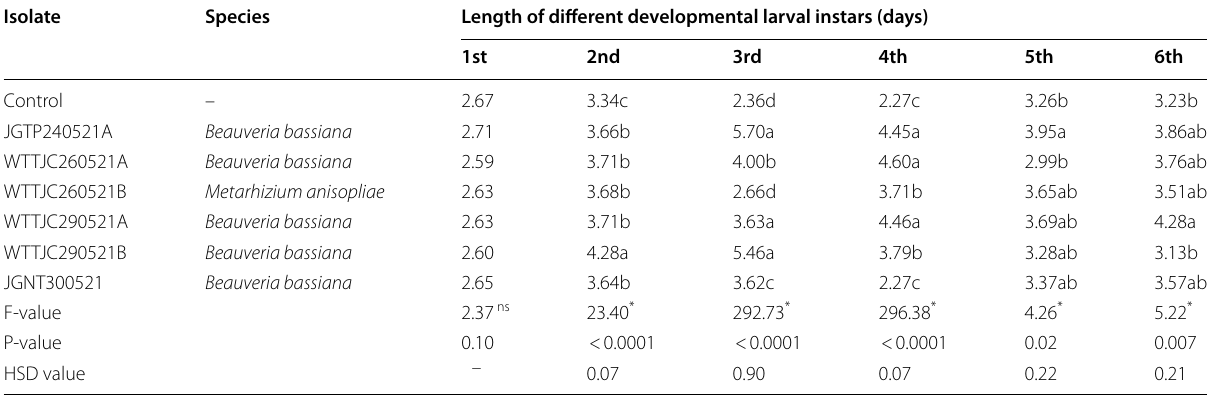
Note: ns not significantly different * significantly different; values within a column followed by the same letters were not significantly different at P < 0.05 = = according to Tukey’s HSD test